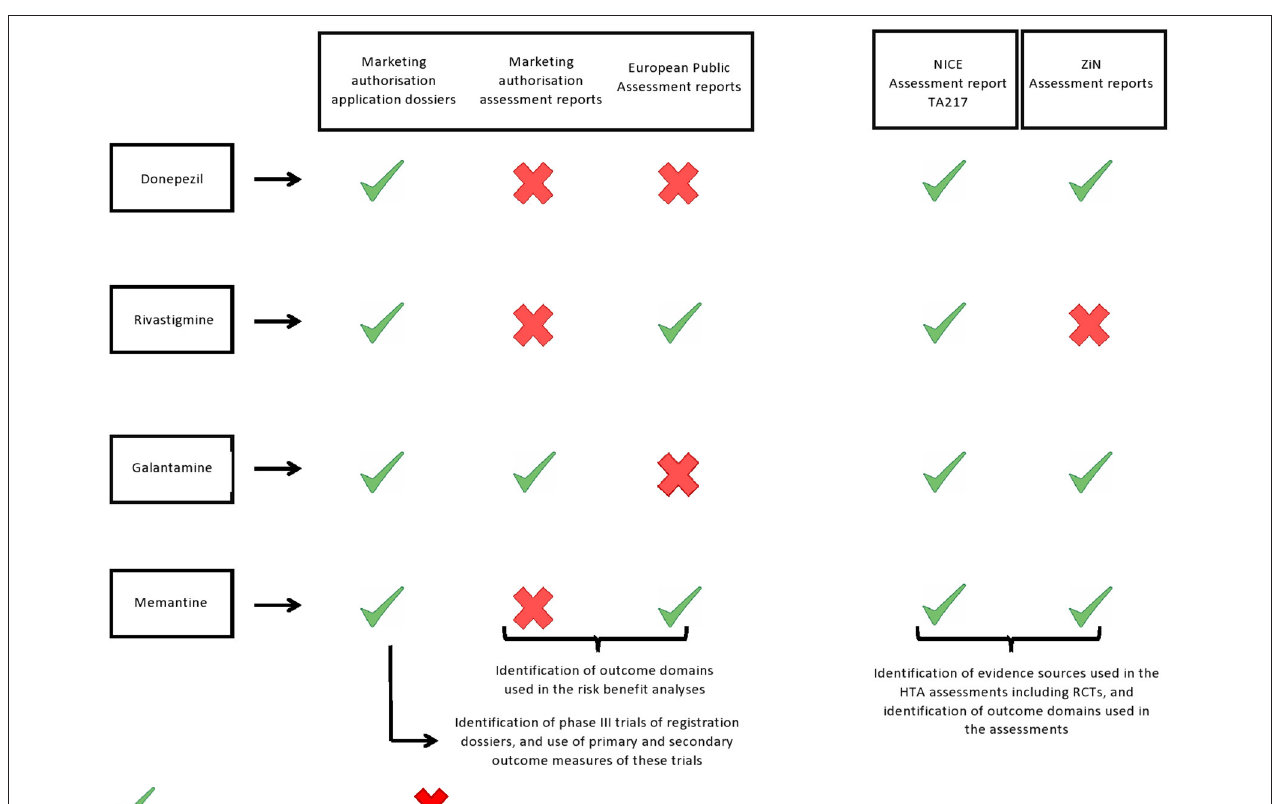
FIGURE 1 | Report was included in our study. Report was not available and was therefore not included in our